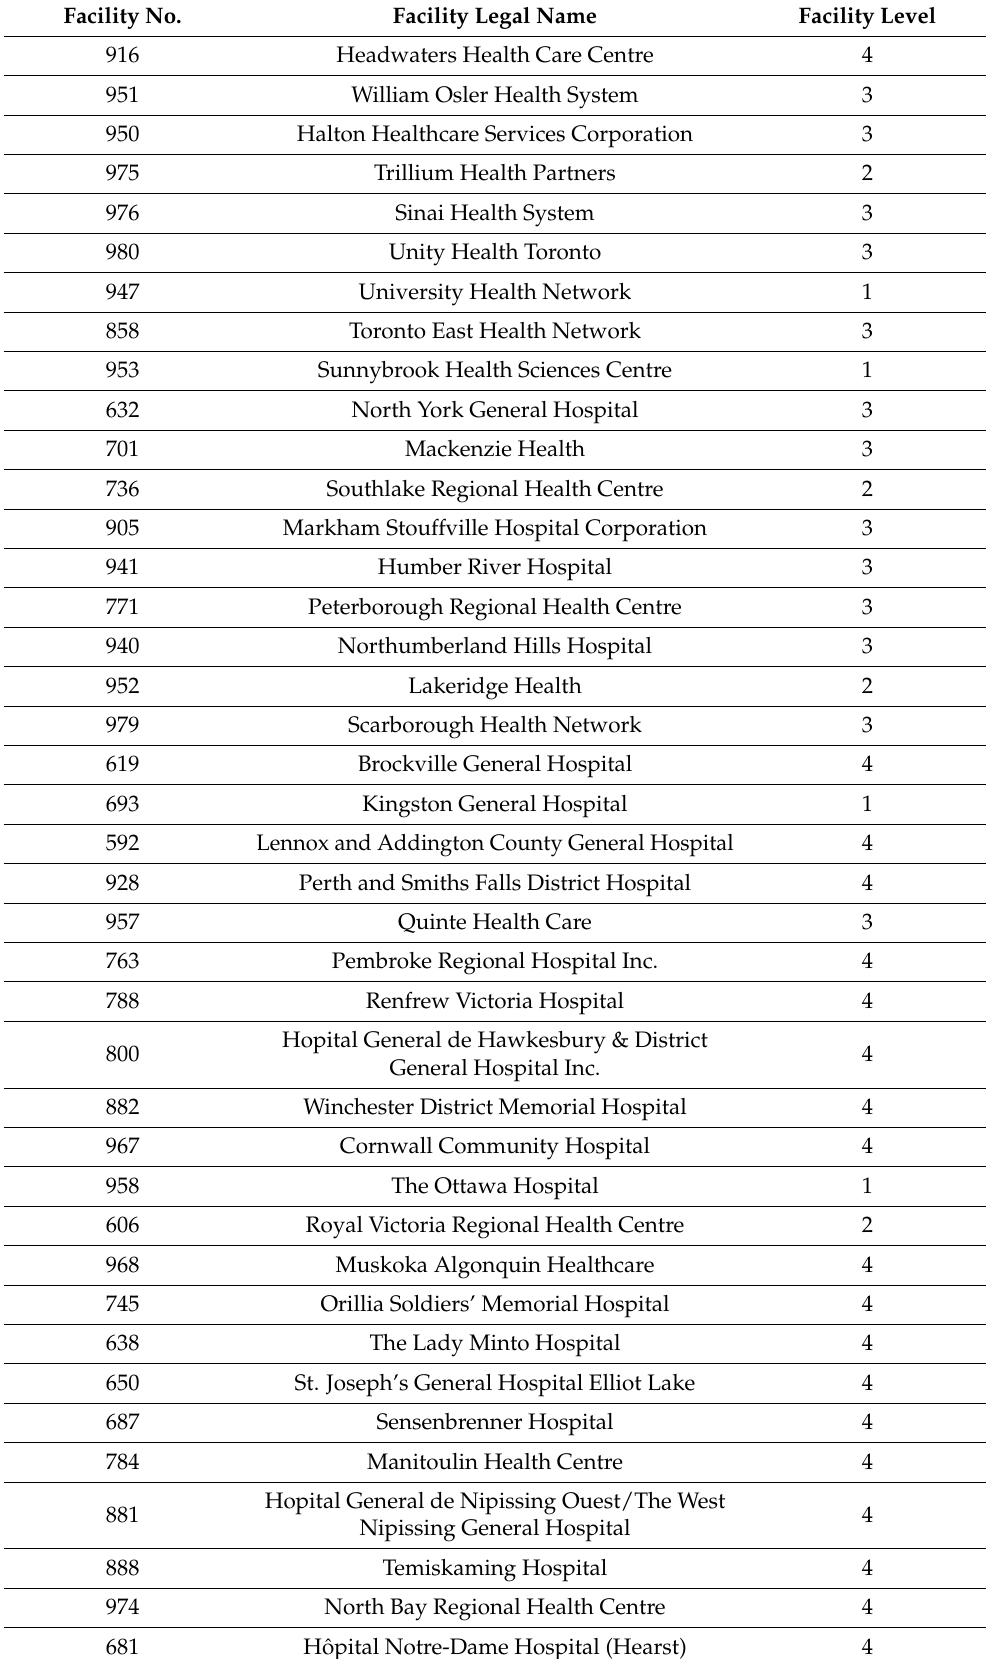
Table A5. Cont. Facility